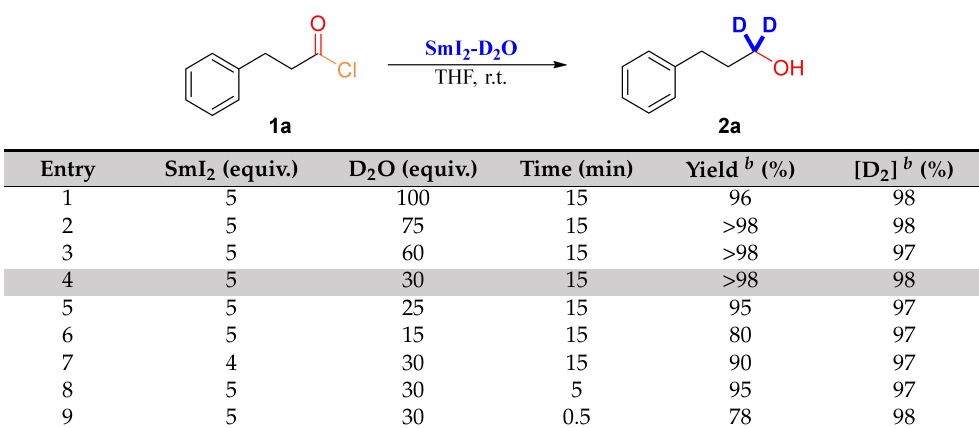
Table 1. Optimization studies of the reductive deuteration of acyl chlorides using SmI 2 -D 2 O a .